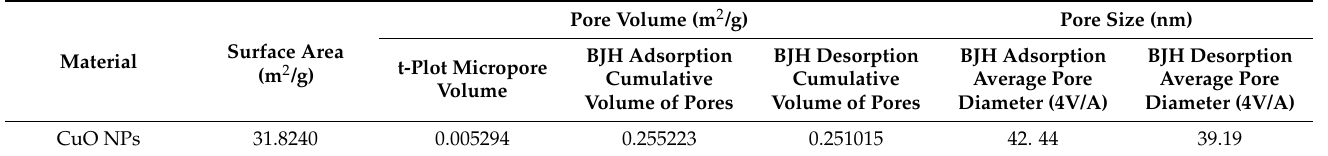
Table 1. Surface area, pore volume, and pore size distribution of CuO NPs by BET